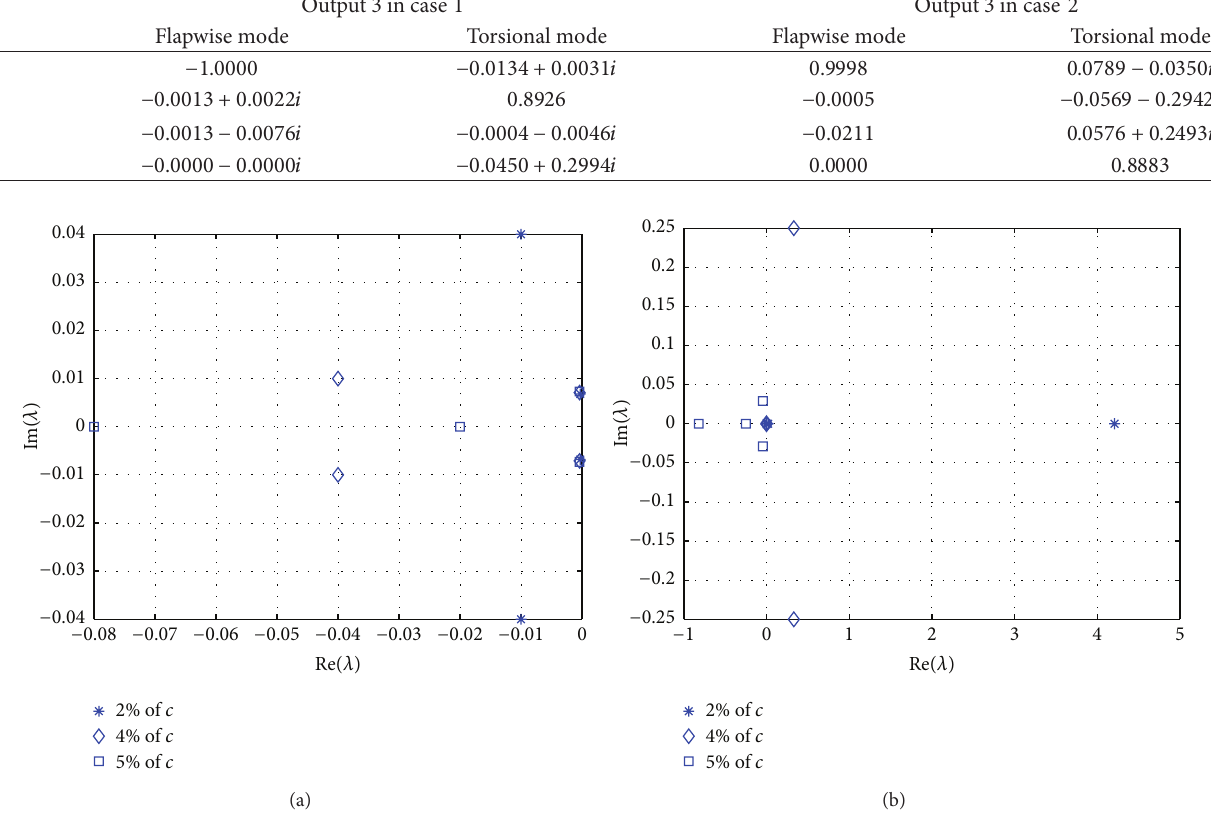
Figure 4: Eigenvalues of the vibration modes with different microtab deployments and output 4 for (a) flutter instability case and (b) divergence instability